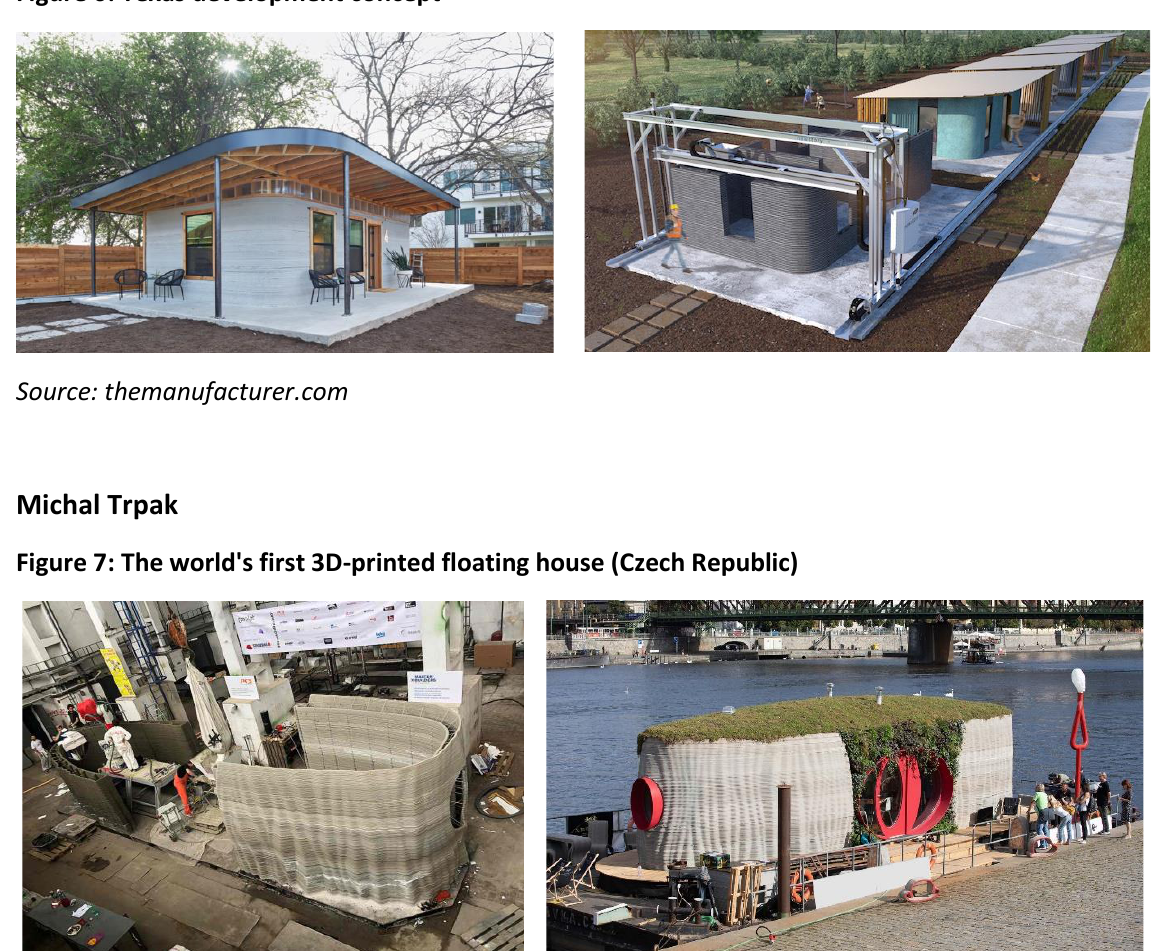
Figure 6: Texas development concept